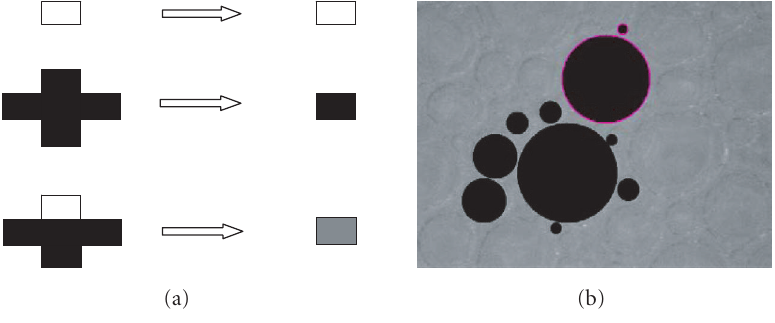
Figure 3.9. Cellular automata are used to estimate the borderlines of the black disks representing the bubbles in the foam: (a) transformation rules of the cellular automaton, (b) black disks and surround- ing borderlines (pink coloured), exemplarily drawn for two bubbles.